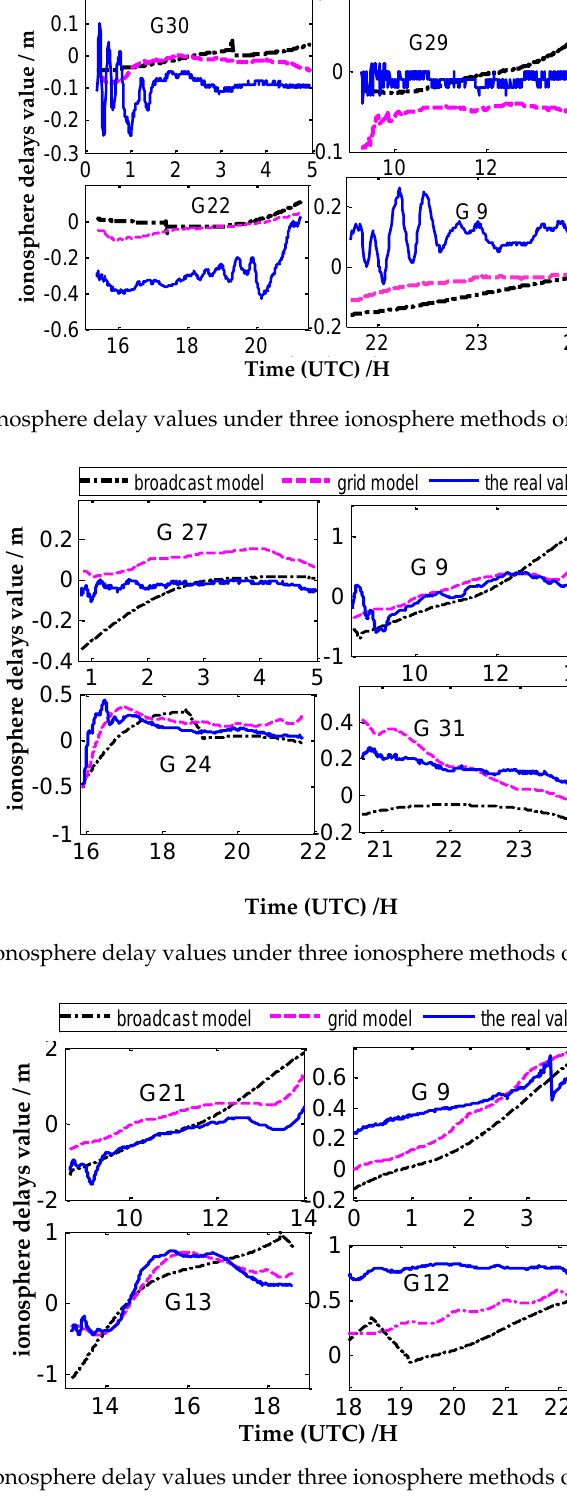
G 31 Figure 8. The ionosphere delay values under three ionosphere methods of VILL and ANKR. 3.2 Process Strategies and Models In order to verify the characteristics of ionosphere impact on time transfer and time comparison, we utilize the data provided by IGS for experimental analysis. First, we analyze the results and accuracy of remote GPS CV without any ionosphere correct. Then, we analyze the results and accuracy of remote GPS CV calculating by three different ionosphere methods: a broadcast model, a grid model, and an ionosphere-free combination method. Then, we take the inter-station clock difference provided by IGS as the true value. The seven-day observed and precise ephemeris data from 24 January 2016 to January 30 2016 of the four groups CV stations mentioned above are utilized, and every day ’ s data is processed separately. The parameter site strategy in this paper is shown in Table 2. The troposphere correction utilizes the Saastamoinen model to correct its dry component, while the remainder of the wet component is estimated by random walk estimation, and we utilize the GMF mapping function to map the zenith delay to the slant observation path [25,26]. Furthermore, the solid Earth tides, relativistic effect, ocean loading, Earth rotation, and satellite antenna phase center deviation are corrected with the corresponding models, while Different Code Bias (DCB) correction utilizes the IGS products [24]. Table 2. The parameters selection methods.